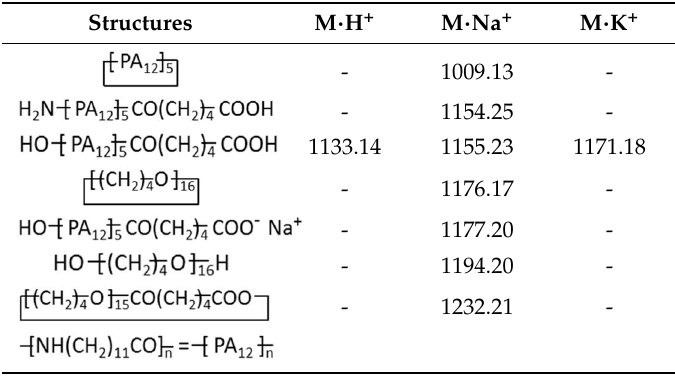
Table 2. Oligomer structures assigned to the mass ions appearing in the matrix-assisted laser desorption ionization (MALDI) spectra of photo-oxidized and pure Pebax ® 2533